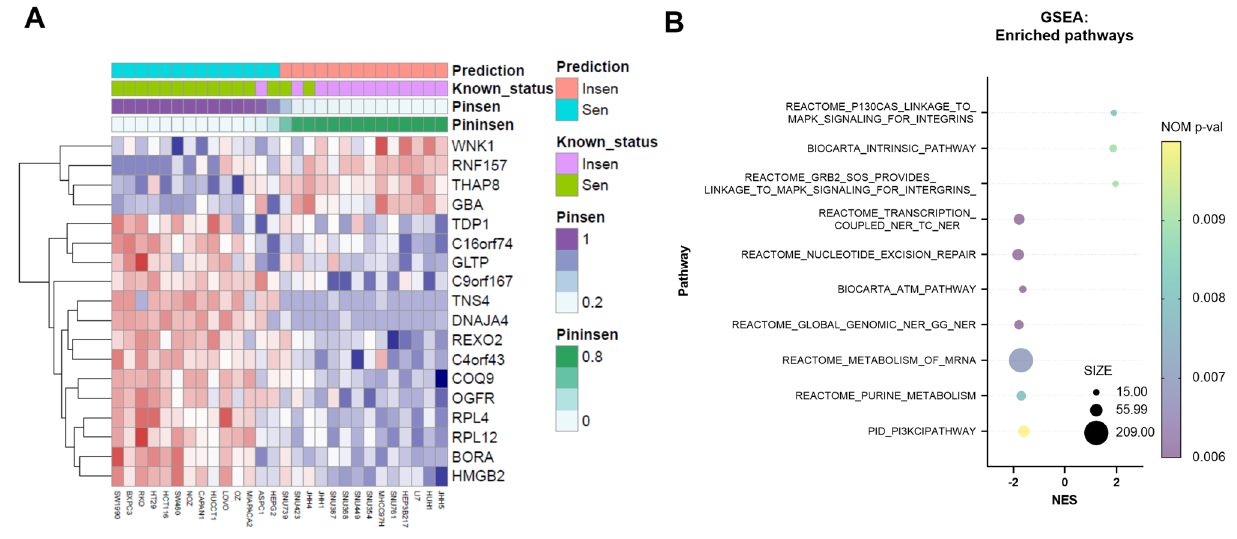
Figure 1. Biomarker discovery for NV651. ( A ) Drug efficacy prediction results using 18 signature genes in 28 grouped cell lines. The probability of being in the sensitive group is indicated as Pinsen and probability of being in the insensitive group is indicated as Pininsen. The drug response of 25 cell lines was correctly predicted. ( B ) Gene set enrichment analysis (GSEA) in 47 cell lines indicating the NES (normalized enrichment score), size and nominal p -value. The correlated genes were enriched in 10 pathways, with a NOM p -value of < 0.01.